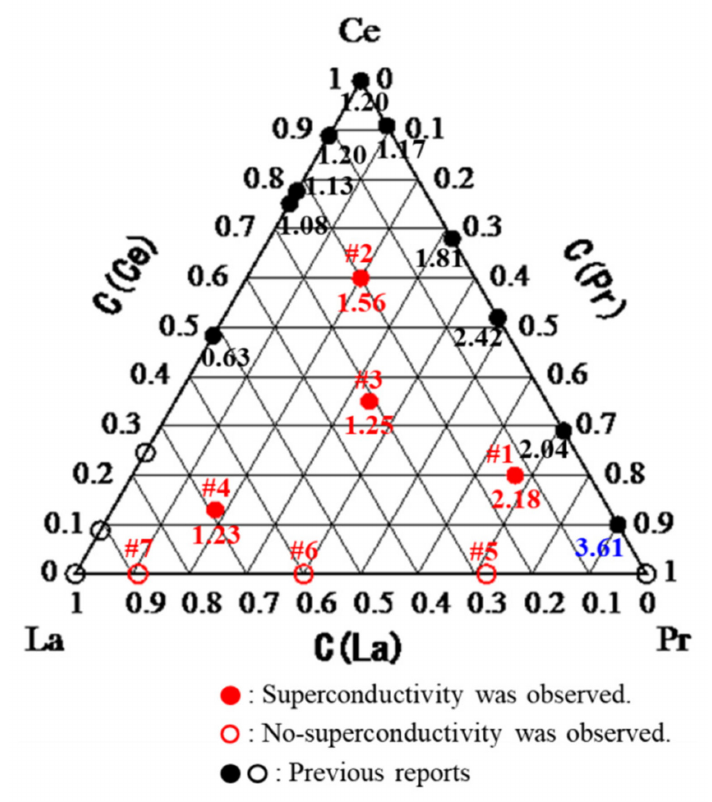
Figure 4. Relationship between the superconducting transition temperature ( T c ) and the compositions of the rare-earth elements (La,Ce,Pr) analyzed. The values in the ternary diagram are T czero , in kelvin (K).